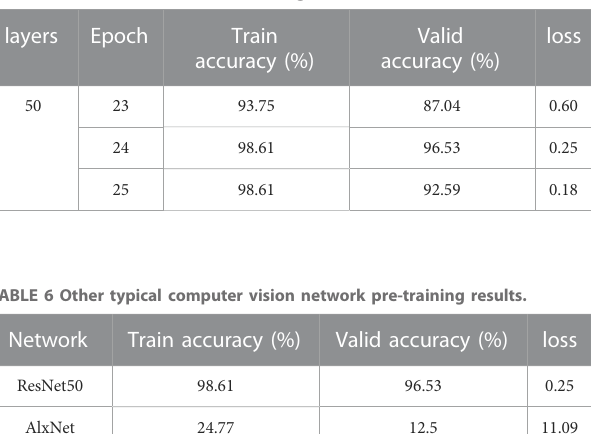
TABLE 5 ResNet50 classi fi cation training results after data enhancement.